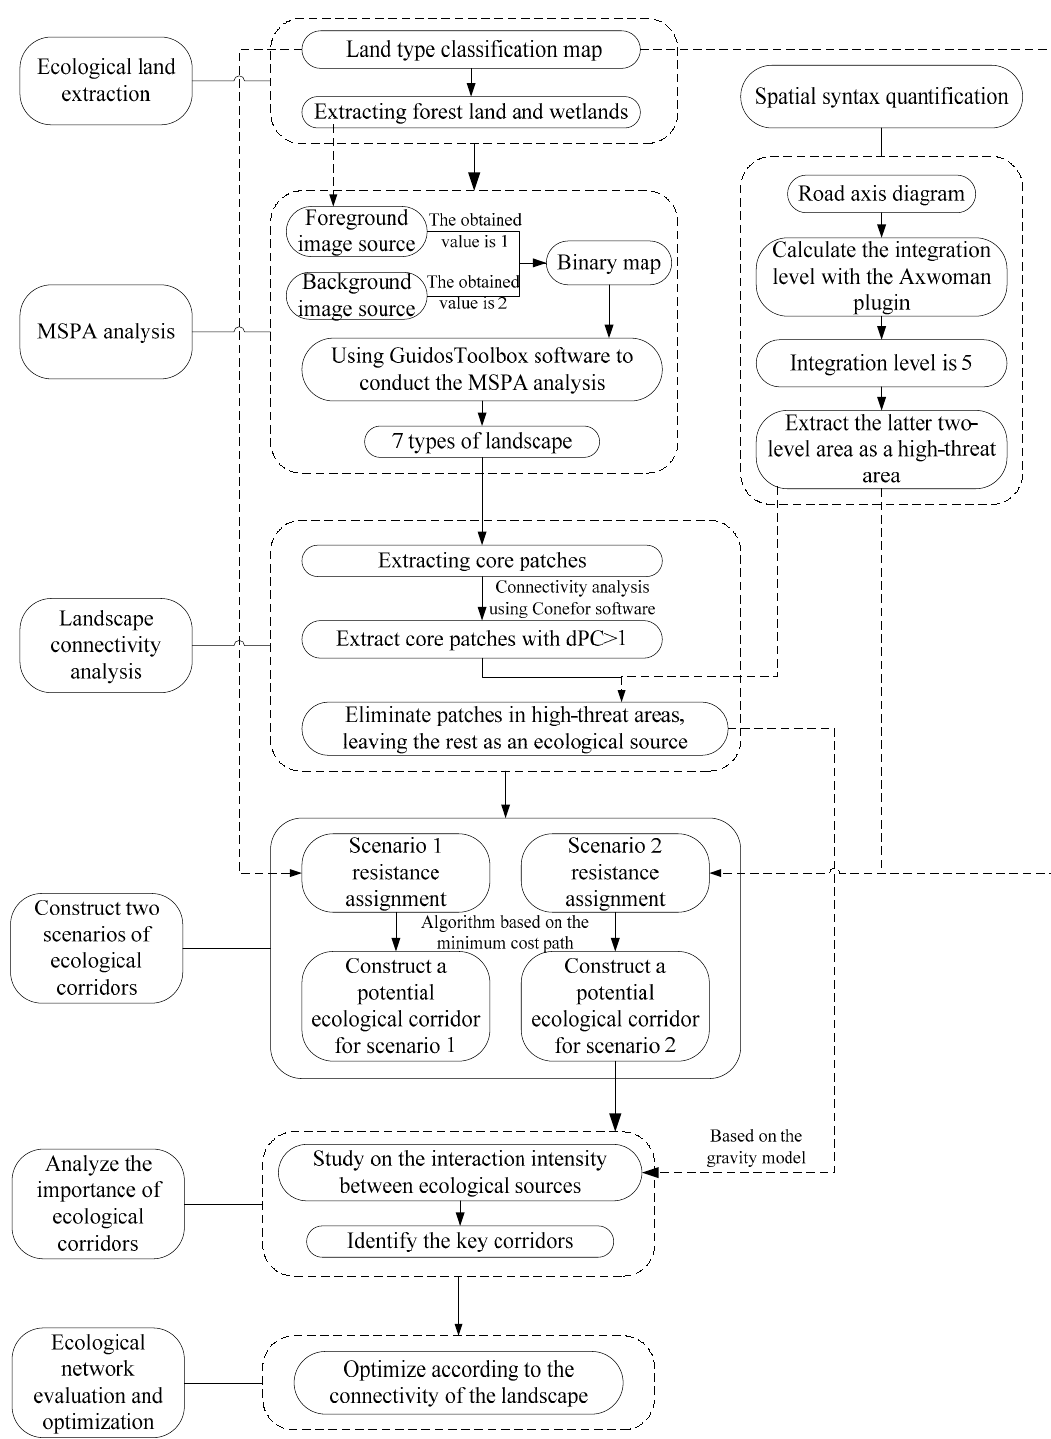
Figure 1. Methodology roadmap.